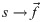
Granger-causal information flows during task →happy in session S02 jointly computed for P01, P04, P05 (participants with good modulation performance).s→f→ indicates causal flow from feedback to brain activity features (top row) and f→→s from brain activity features to feedback (bottom row). The g-causalities are statistically tested for significance (p < 0.01) and Bonferroni-corrected.